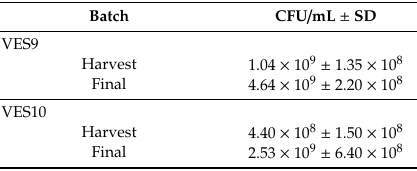
Table 1. The average CFU / mL of M. bovis Bacillus of Calmette and Gu é rin (BCG) used for vaccination in studies VES9 & VES10 for the pooled harvest for each BCG batch and the final, concentrated, suspension.